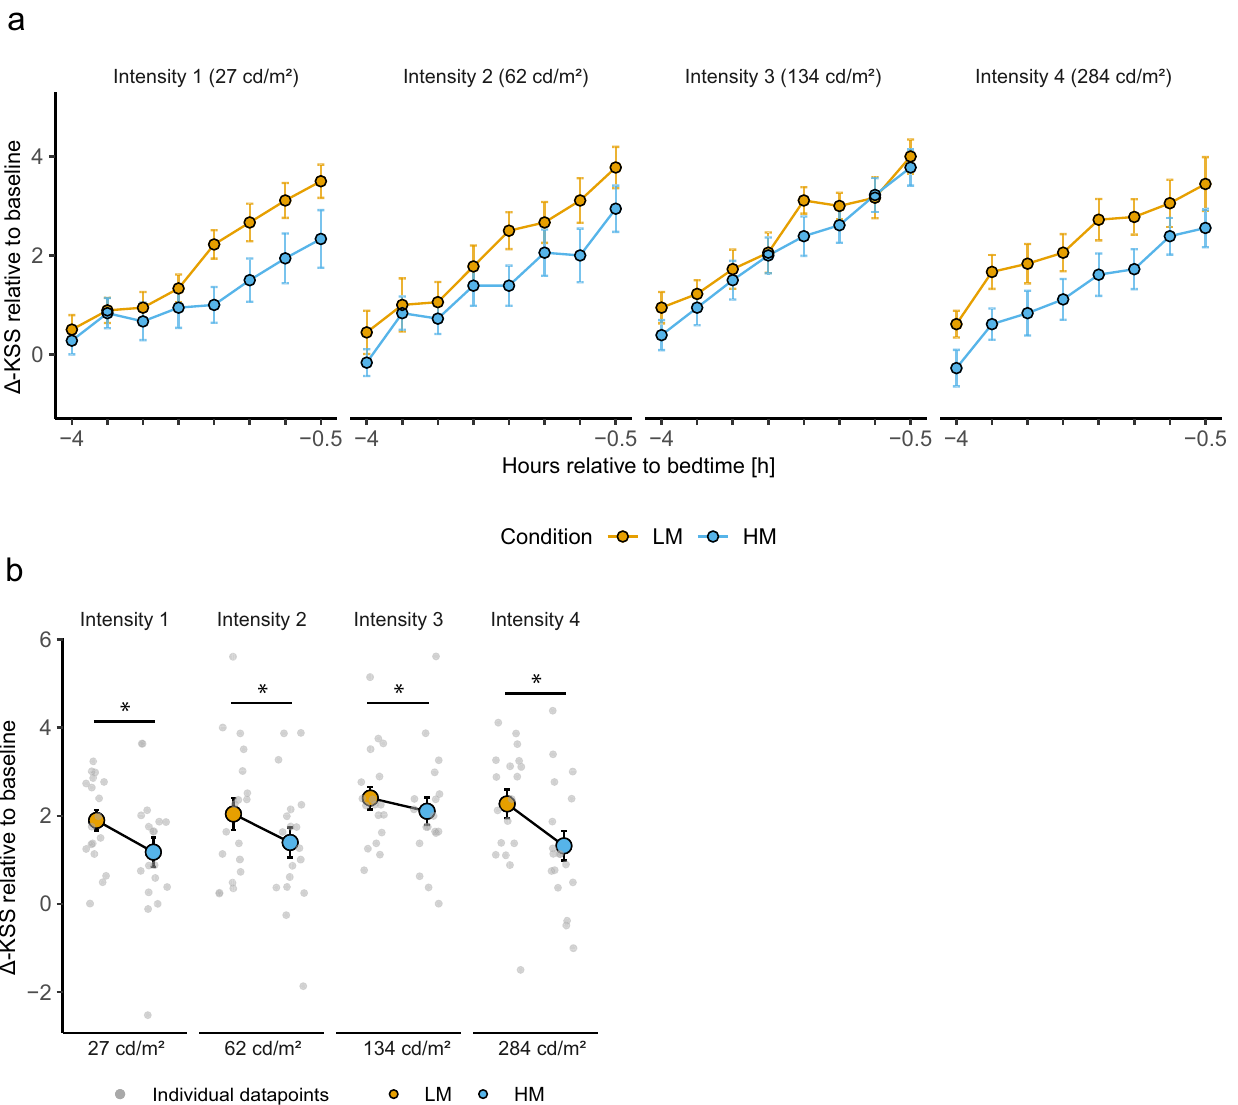
Fig. 4 Results of subjective alerting response during light exposure. a Time course of subjective sleepiness ratings (KSS) during the low melanopic (LM: orange points and lines) and high melanopic (HM: blue points and lines) light conditions plotted against the hours relative to bedtime [h]. Individual sleepiness ratings were corrected with the last sleepiness rating before light exposure, showing the difference to the pre-light exposure level. Depicted are means ± 1SEM ( n = 18 per intensity group). b Baseline-corrected subjective sleepiness ratings (KSS) for LM (Mean: orange points; SEM: black lines) and HM (Mean: blue points; SEM: black lines) during light exposure. Values shown are means of eight time assessments ±1SEM. Grey points represent the individual values of participants. The black asterisks indicate the statistically signi fi cant main effect ( p < 0.05) of the fi xed factor light condition, computed in a linear mixed